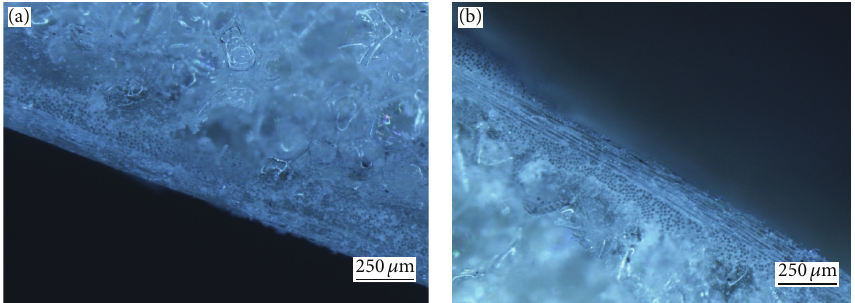
Figure 3: A comparison of structural skins in composites produced by means of (a) press method and (b) in the autoclave.